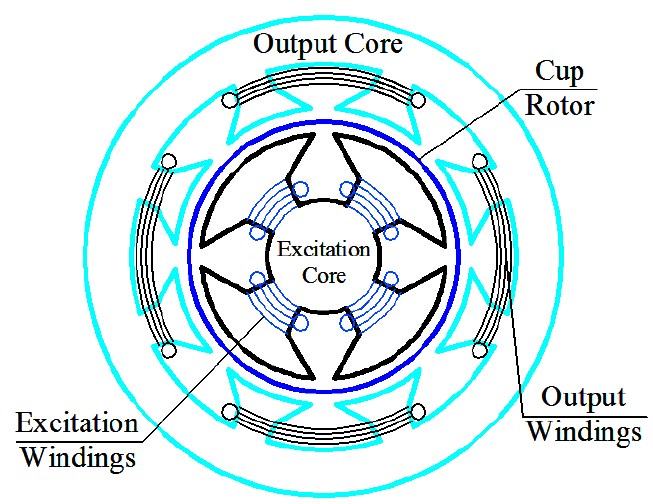
Figure 3. Sectional sketch view of the